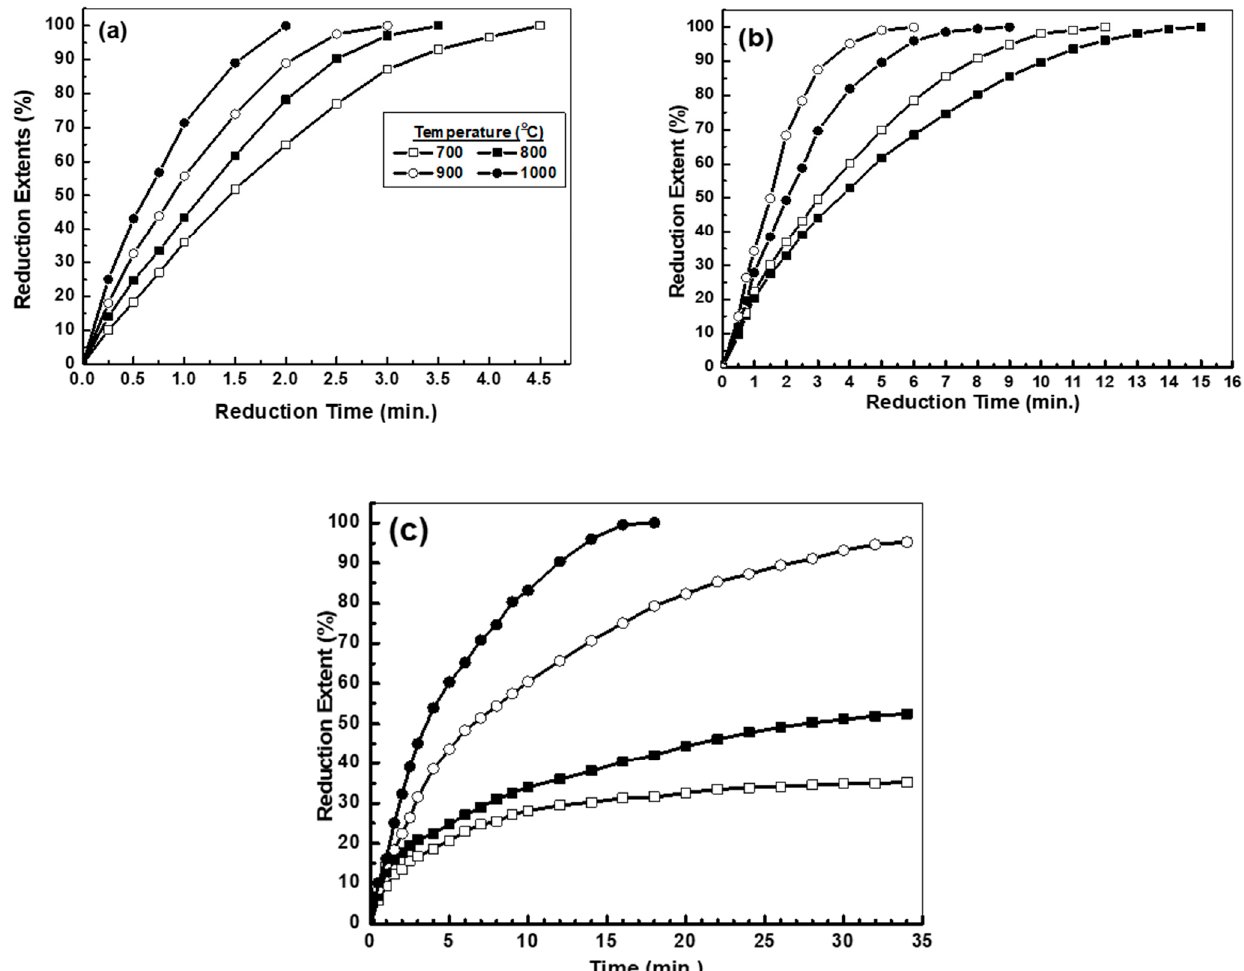
Figure 4. Isothermal reduction behavior of nanosized metal oxides reduced with H 2 at 700–1000 °C: ( a ) NiO; ( b ) Fe 2 O 3 ; ( c ) WO 3 .